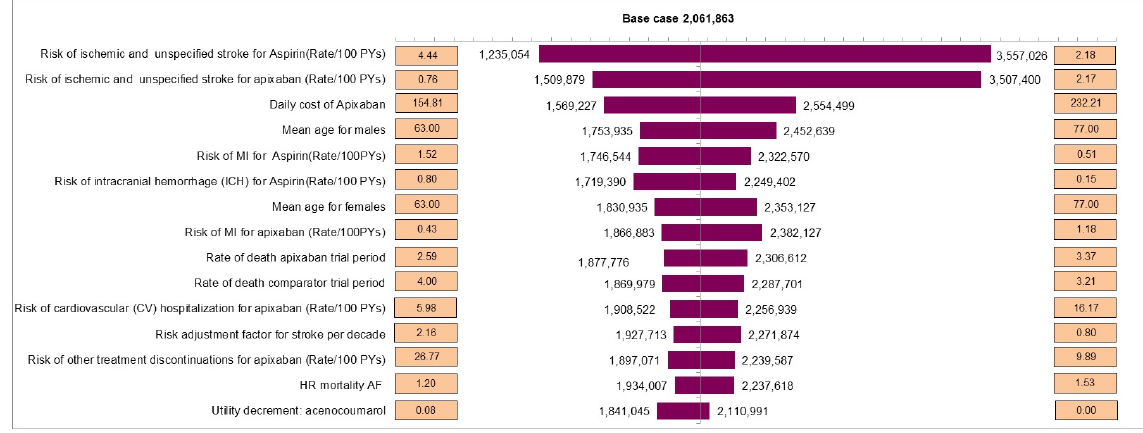
Figure 2a. Tornado Chart for Apixaban versus Aspirin in the VKA-unsuitable Population (ICER)*